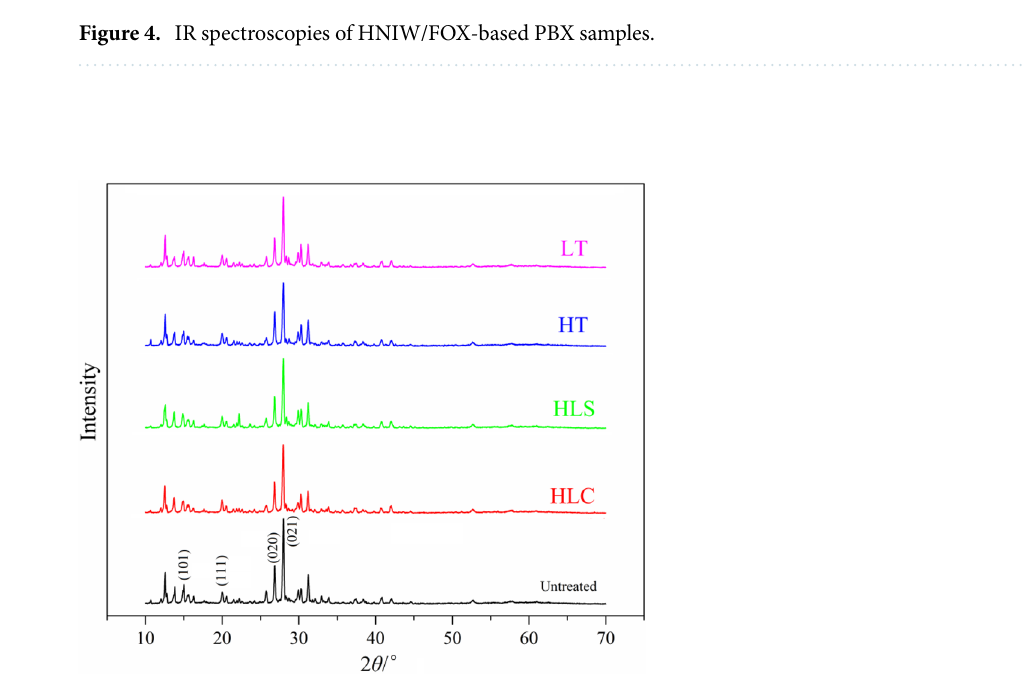
Figure 5. XRD spectroscopies of HNIW/FOX-based PBX